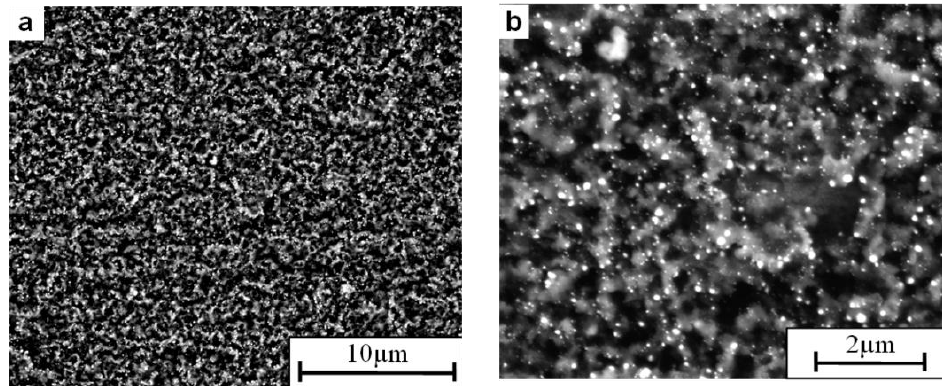
Figure 3. SEM morphology of carbon nanofibres (CNFs) deposited on the surface of Ni 3 Al